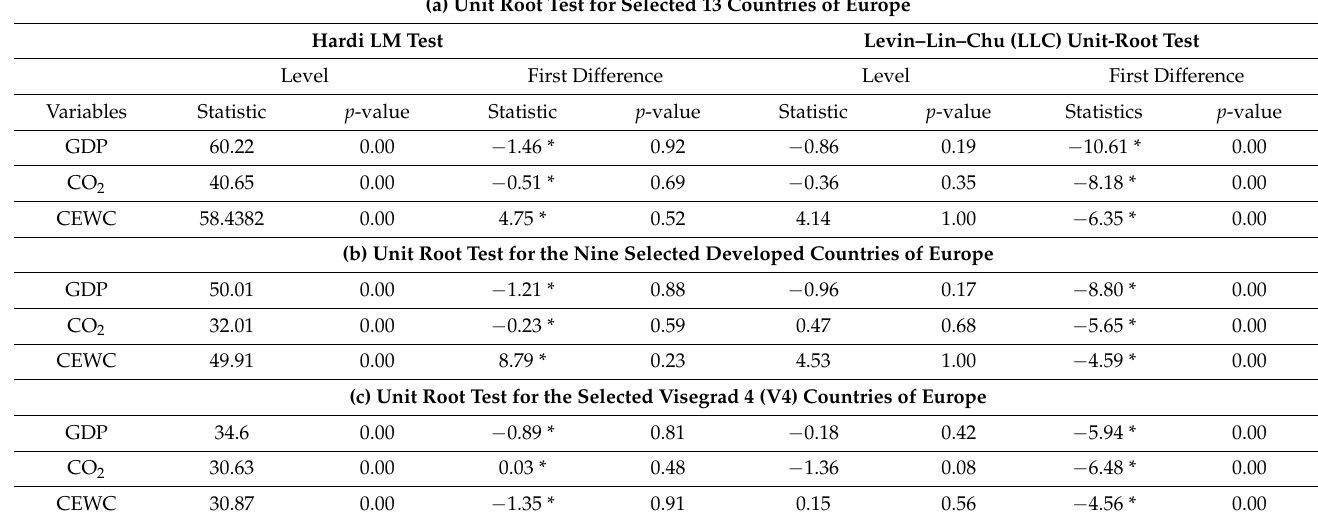
Table 3. Results of Stationary